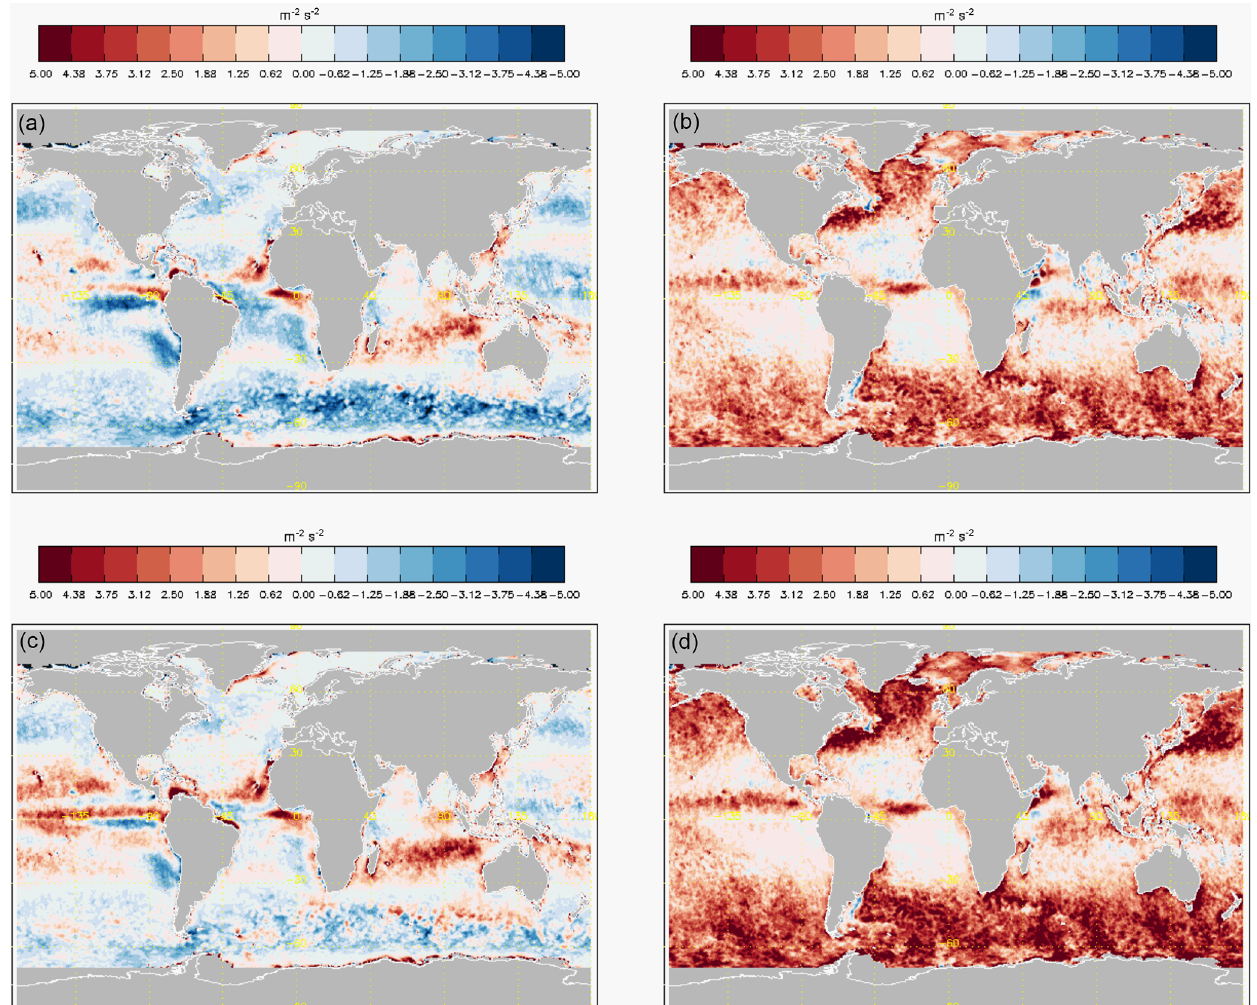
Figure 14. MKE (a, c) and EKE (b, d) differences between ASCAT and ERA5 before (a, b) and after (c, d) ocean current correction over